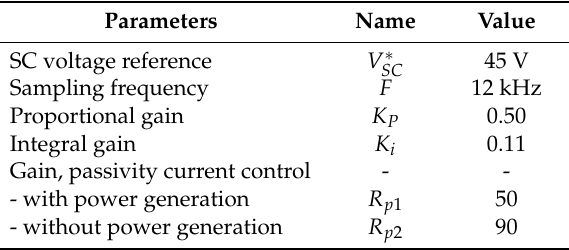
Table 2. Control scheme parameters.